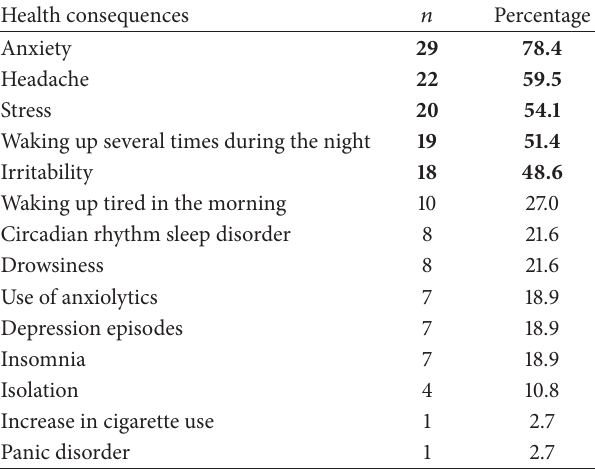
Table 3: Frequency of biopsychosocial consequences for the health